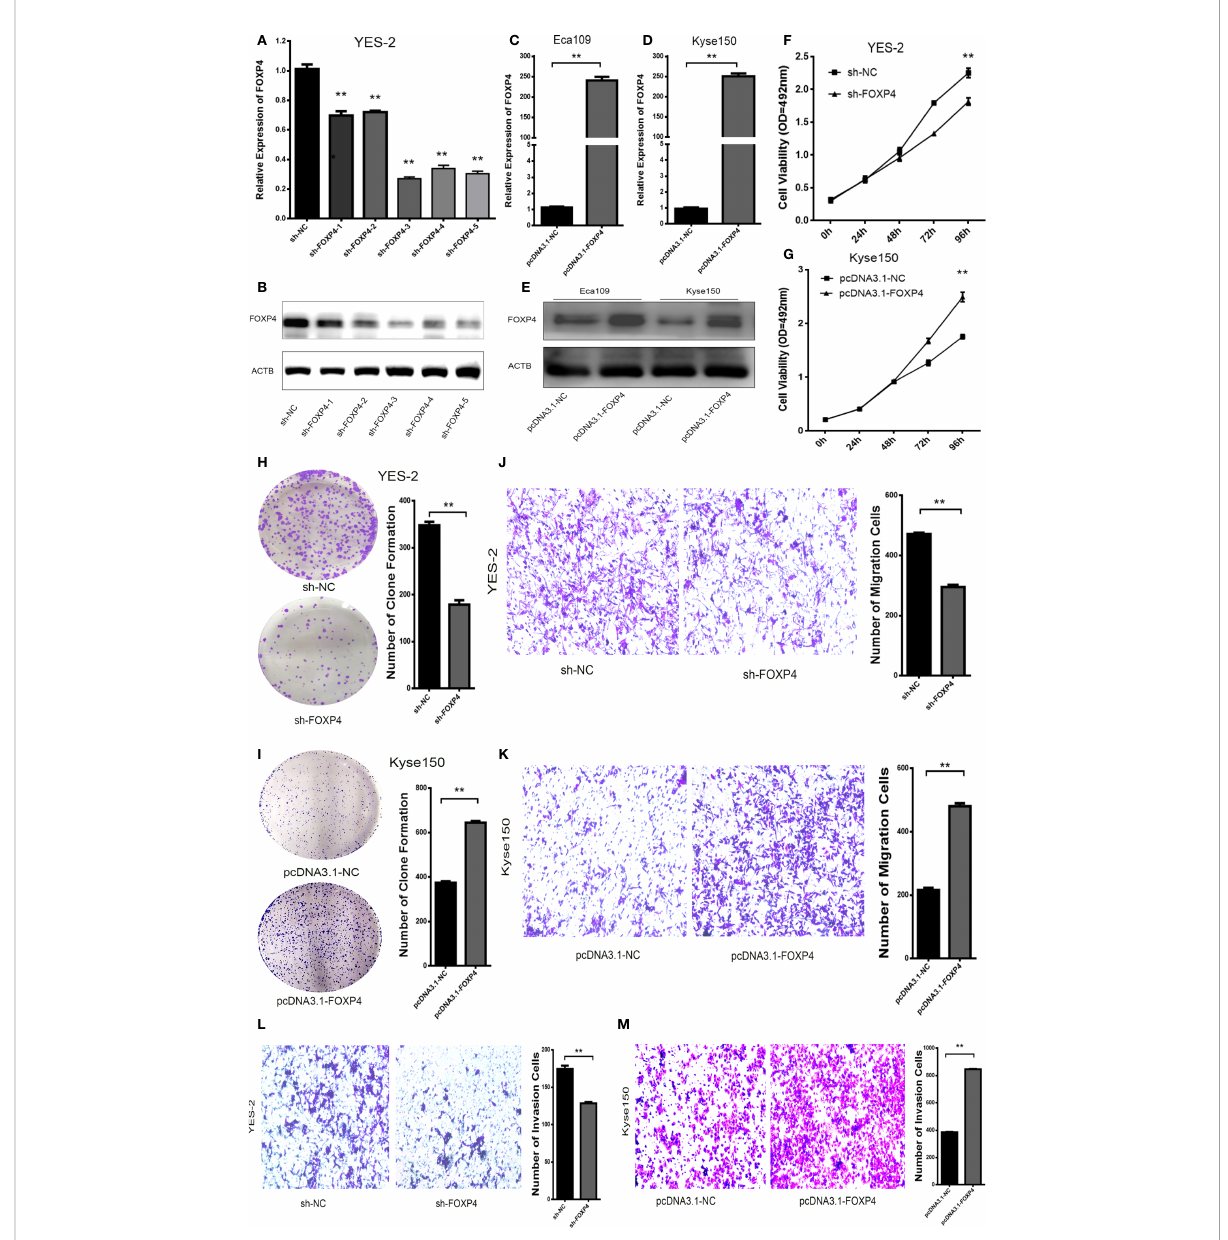
FIGURE 5 FOXP4 promotes the malignant progression of ESCC. The expression of FOXP4 mRNA (A, C, D) and protein (B, E) in transfected sh-FOXP4 or pcDNA3.1-FOXP4 by qRT – PCR or WB. (F) MTS assay showing the inhibition of YES-2 proliferation ability with sh-FOXP4. (G) Increased proliferative capacity of Kyse150 with pcDNA3.1-FOXP4 by MTS assay. (H) Colony formation assay indicated that deregulated FOXP4 follows the lower colony formation in YES-2 cells. (I) Enhanced colony formation in Kyse150 cells with pcDNA3.1-FOXP4. Transwell migration (J) and invasion assays (K) show the decreased trans-cells of YES-2 with sh-FOXP4. Transwell migration (L) and invasion assay (M) demonstrated more Kyse150 trans-cells with pcDNA3.1-FOXP4. ** p <